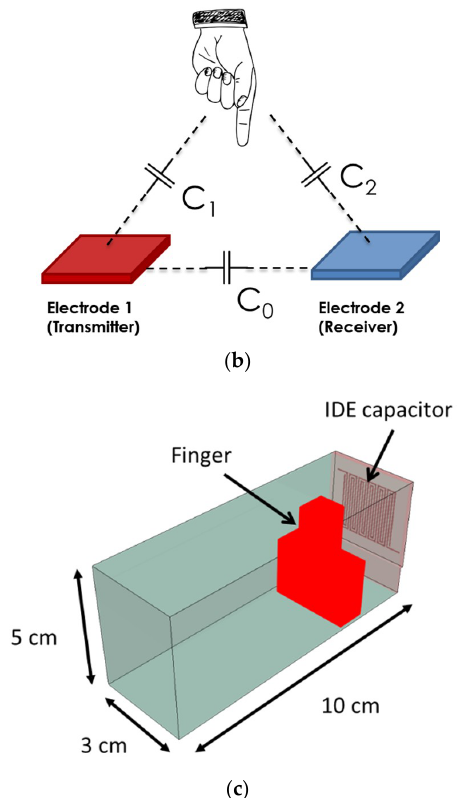
Figure 5. ( a ) Photo images showing the testing setup where a human finger is positioned at different positions above the IDE capacitor. ( b ) Illustration of the different capacitance paths as a human finger approaches the capacitor. C 0 is the intrinsic capacitance and C 1 C 2 are the parasitic capacitances. ( c ) FE model in the numerical simulation (finger and IDE capacitor indicated) with a size of 10 cm × 5 cm × 3 cm.